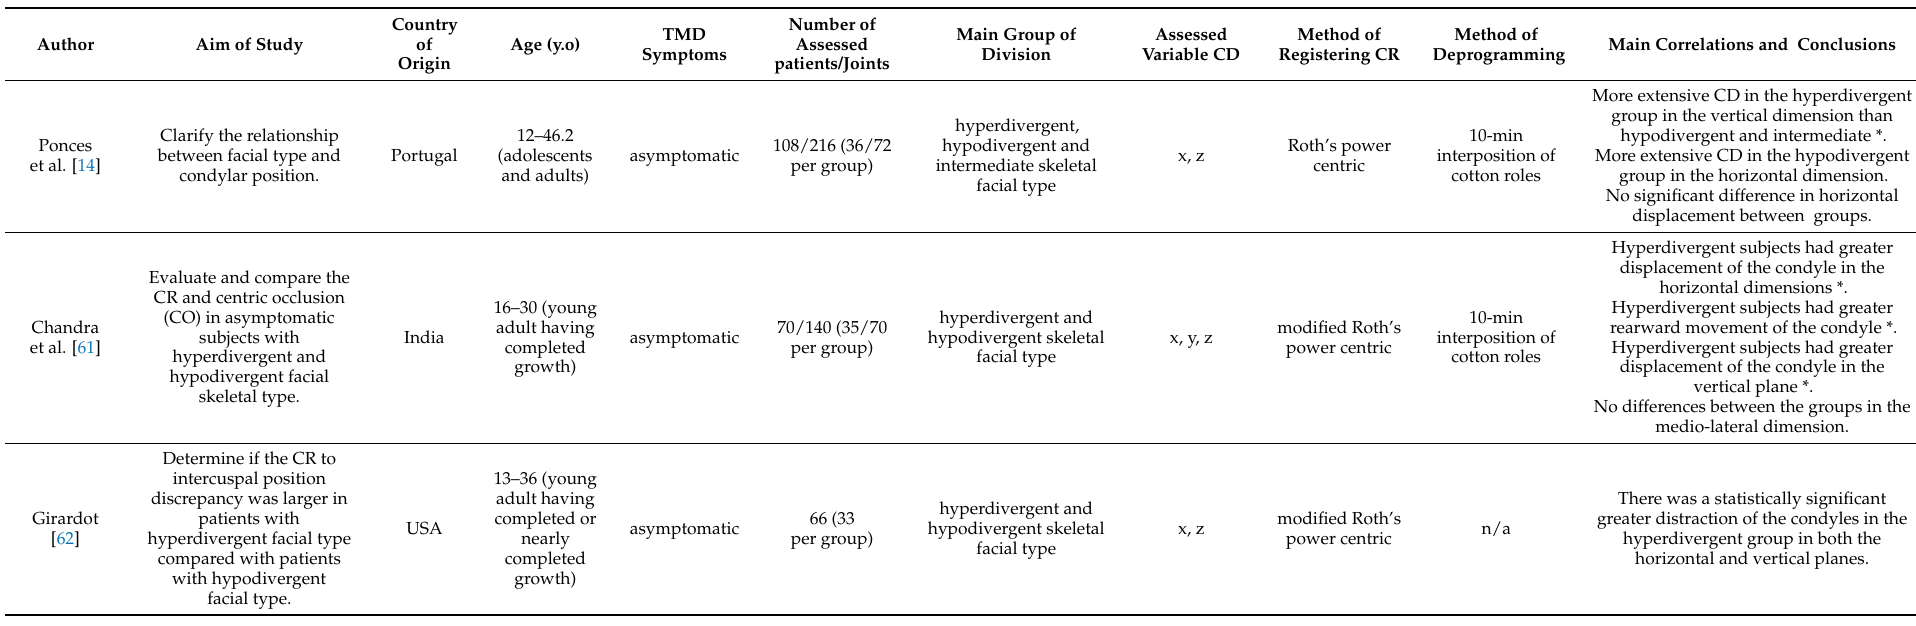
Table 3. Summary of the descriptive characteristics of included